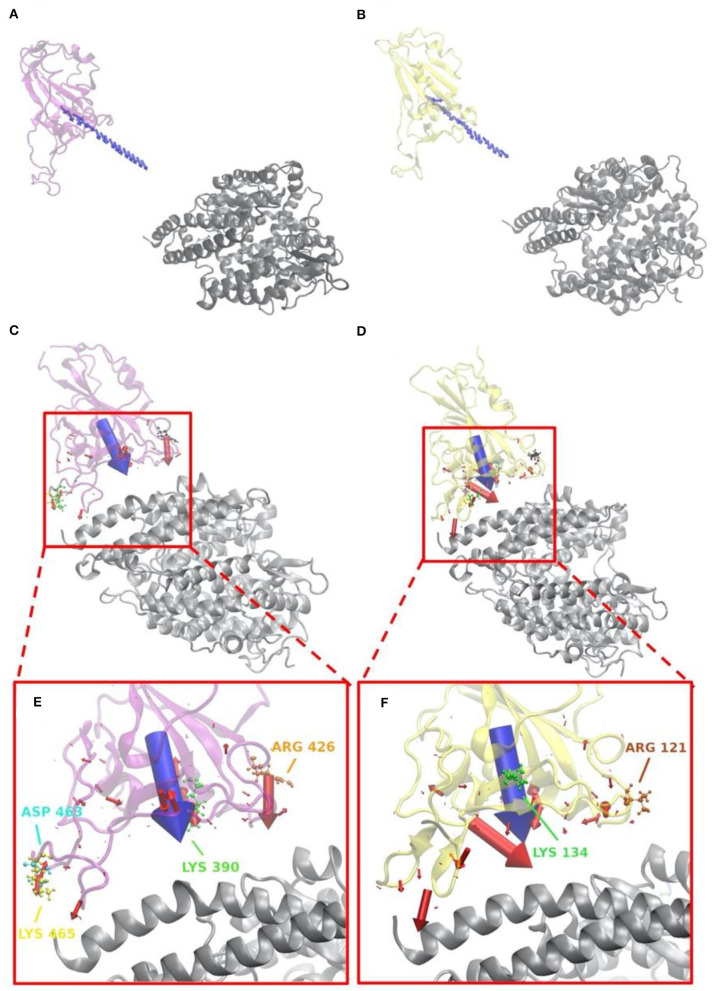
Electrostatic forces of SARS-CoV S protein RBD and SARS-CoV-2 S protein RBD at variable distances with human ACE2 binding domain. (A) Electrostatic forces of SARS-CoV S protein RBD with human ACE2 RBD at a different distance, from 5 to 40 with a step of 2 Å, where blue arrows show the net force directions. (B) Electrostatic forces of SARS-CoV-2 S protein RBD with human ACE2 RBD at different distance, from 5 to 40 with a step of 2 Å, where blue arrows show the net force directions. (C) Electrostatic forces of SARS-CoV S protein RBD with human ACE2 RBD at a distance 5 Å, where the blue arrow shows the total net force between S protein and ACE2, and red arrows represent individual forces between single residues of S proteins in interface area and ACE2. (D) Electrostatic forces of SARS-CoV-2 S protein RBD with human ACE2 RBD at a distance of 5 Å, where the blue arrow shows the total net force between S protein and ACE2, and red arrows represent individual forces between single residues of S proteins in interface area and ACE2. (E) A closeup view of (C) in the interface. (F) A closeup view of (D) in the interface.